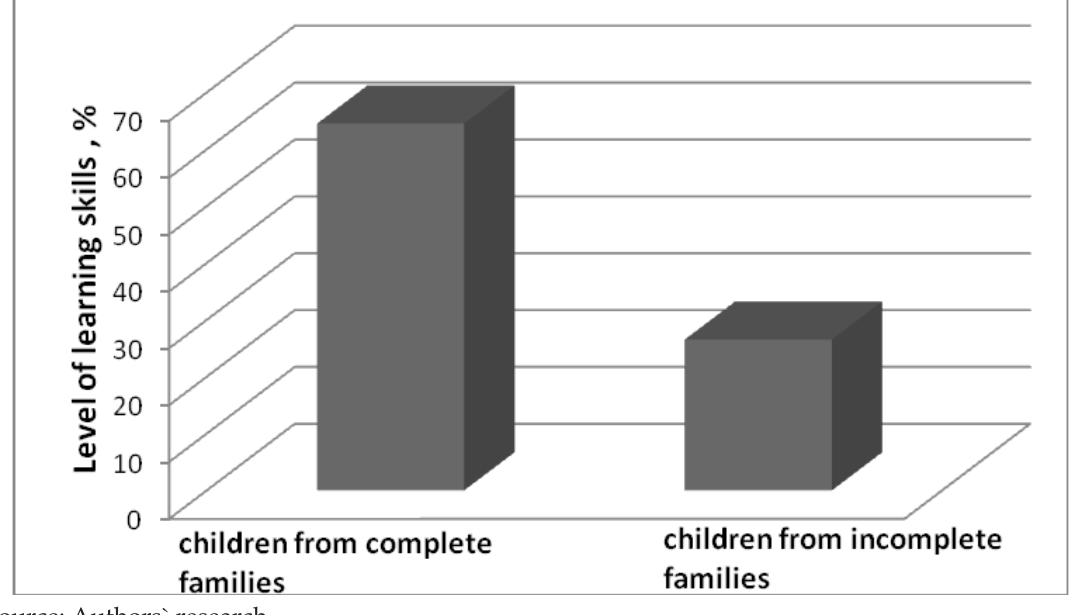
Fig. 3. Differences in the level of formation of learning skills among children with nuclear and single parent families according to method “Pattern” by Larisa Tsehanskaya.